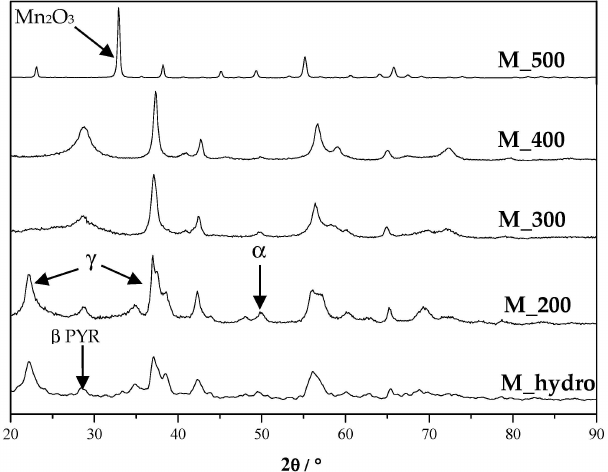
Figure 4. XRPD patterns of MnO 2 samples calcined at different temperatures. The most significant reflections for γ -MnO 2 nsutite, β -MnO 2 pyrolusite, α -MnO 2 hollandite and Mn 2 O 3 bixbite are